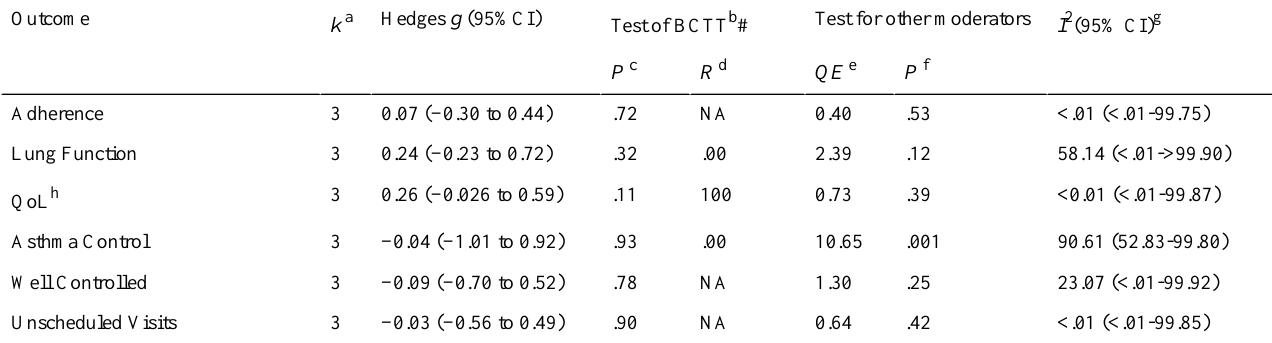
Table 8. Continuous moderation analysis for number of behavior change technique (BCT) on relationship between mobile technology intervention, adherence, and clinical